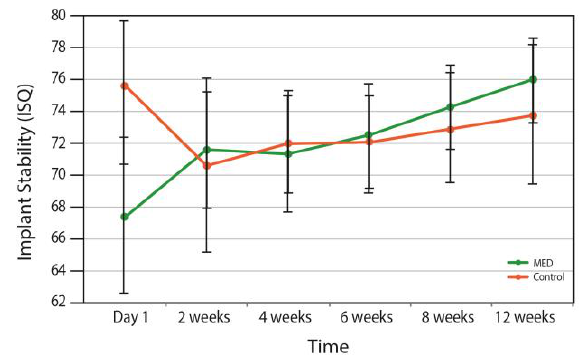
Figure 2. Changes in implant stability in the MED and control groups over time.